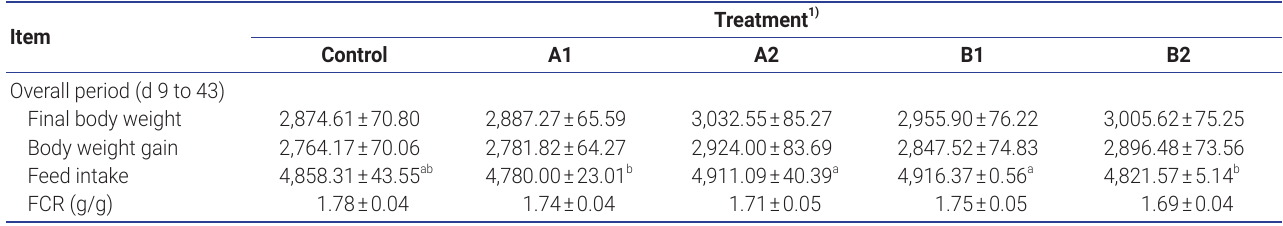
Table 2. Effects of dietary metallo-protease and Bacillus velezensis CE 100 addition for overall period on growth performance in broilers (g)